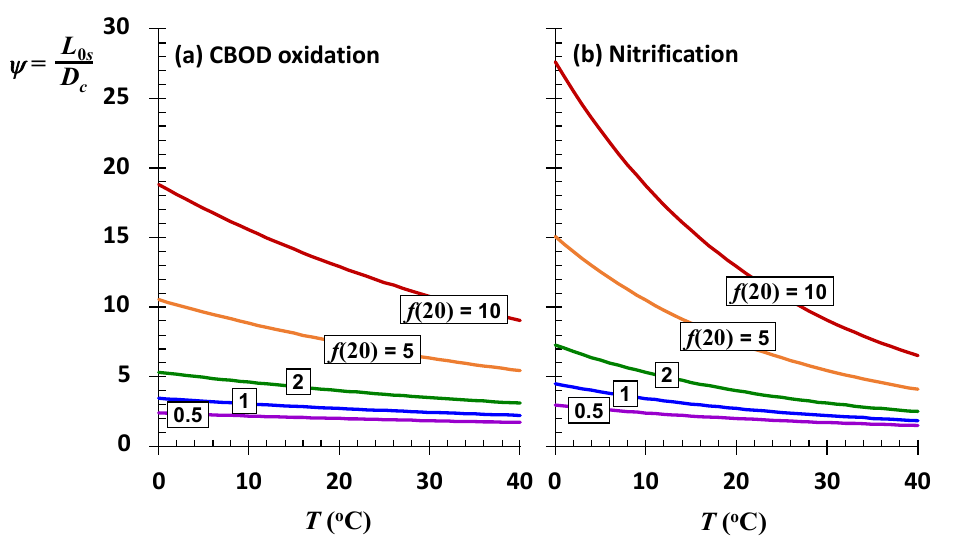
Figure 7. Plot of ψ , the ratio of the sustainable mixing-point BOD concentration ( L 0s ) to the critical deficit ( D c ) versus temperature for sea-level rivers with different values of the 20 ◦ C self-purification constant.